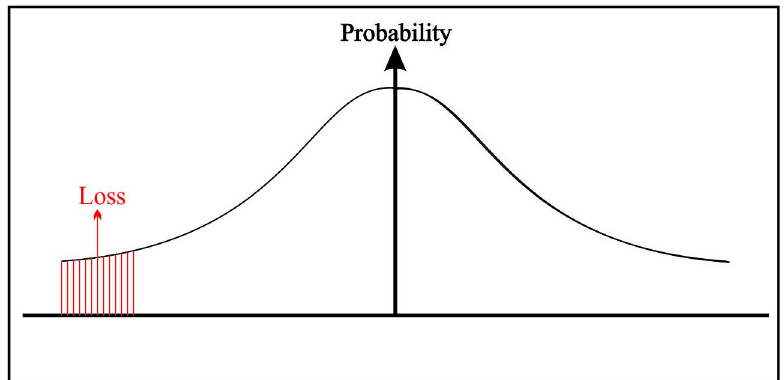
Fig 2. TDM based on the loss tail under PIVHF environment.